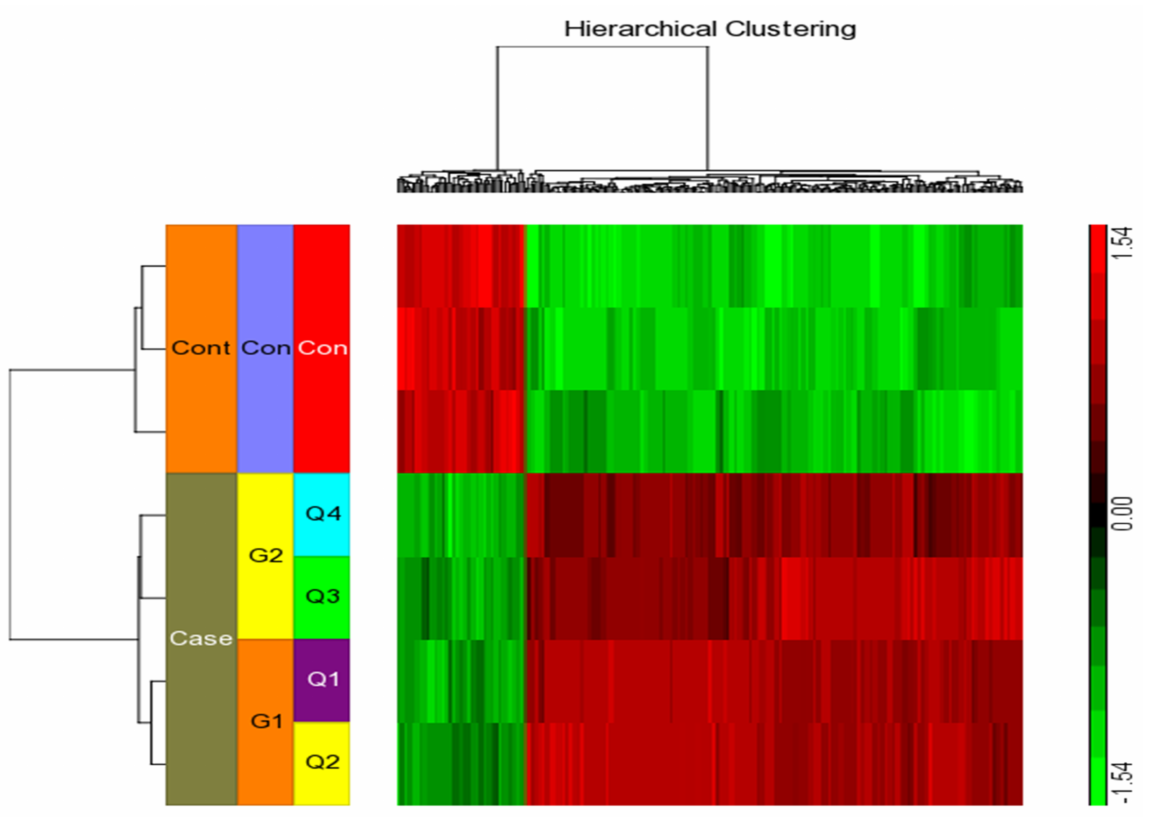
Figure 5. Using the Affymetrix Human ST 1.0 array and the Partek GS 7.0 software, we performed hierarchical clustering and functional analysis on chosen genes that were substantially differently expressed in treated